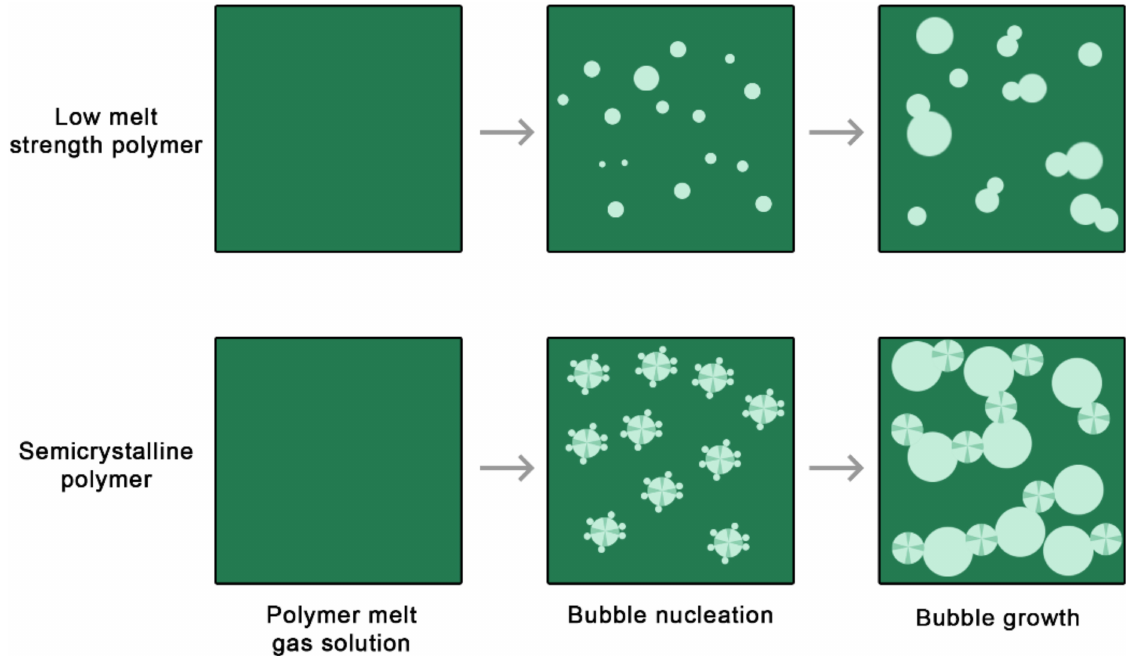
Figure 4. Low melt strength polymers do not yield foams with suitable morphology due to cell coalescence ( top scheme). Crystal formation during the foaming of semicrystalline polymers can restrict cell coalescence ( bottom